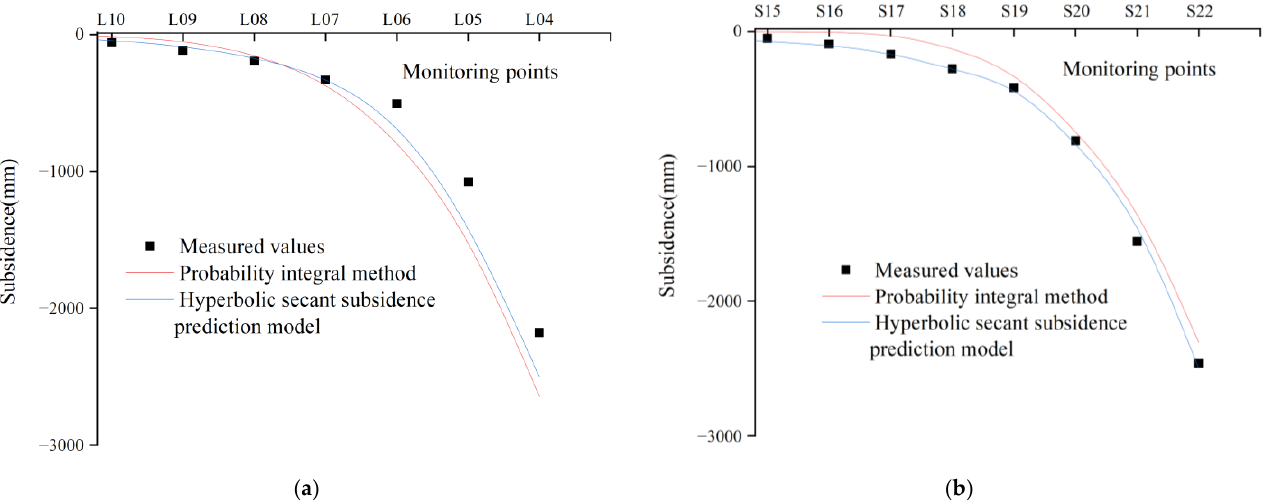
Figure 14. Comparison of predicted values of subsidence boundaries of different models. ( a ) Pre- dicted values of L-line. ( b ) Predicted values of S-line.